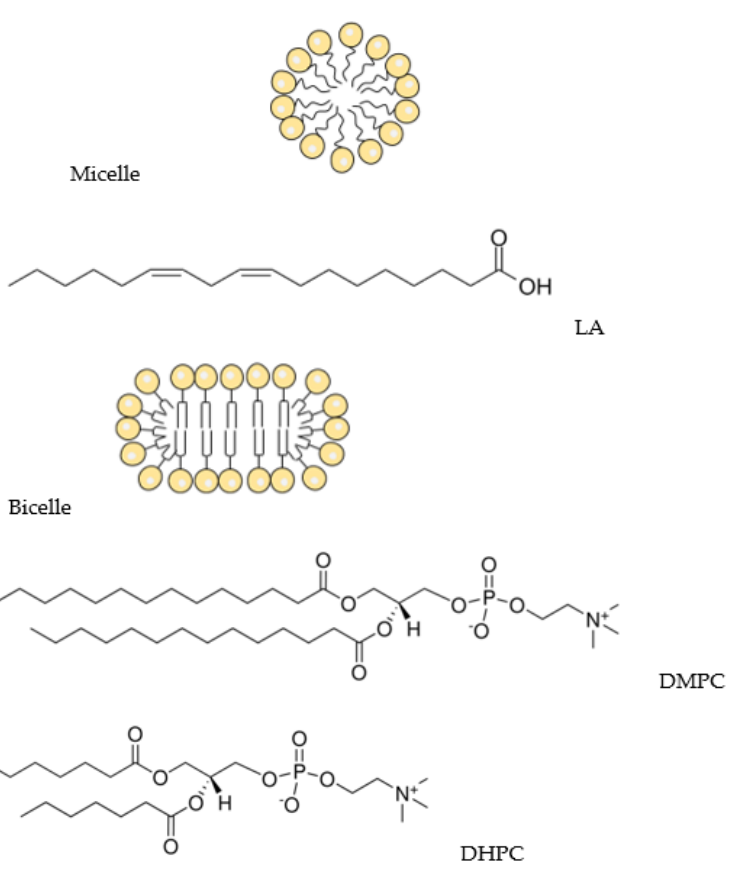
Figure 2. Schematic representation of the micelle and the bicelle and structures of linoleic acid (LA), DMPC (1,2-dimyristoyl-sn-glycero-3-phosphocholine), and DHPC (1,2-diheptanoyl-sn-glycero-3-